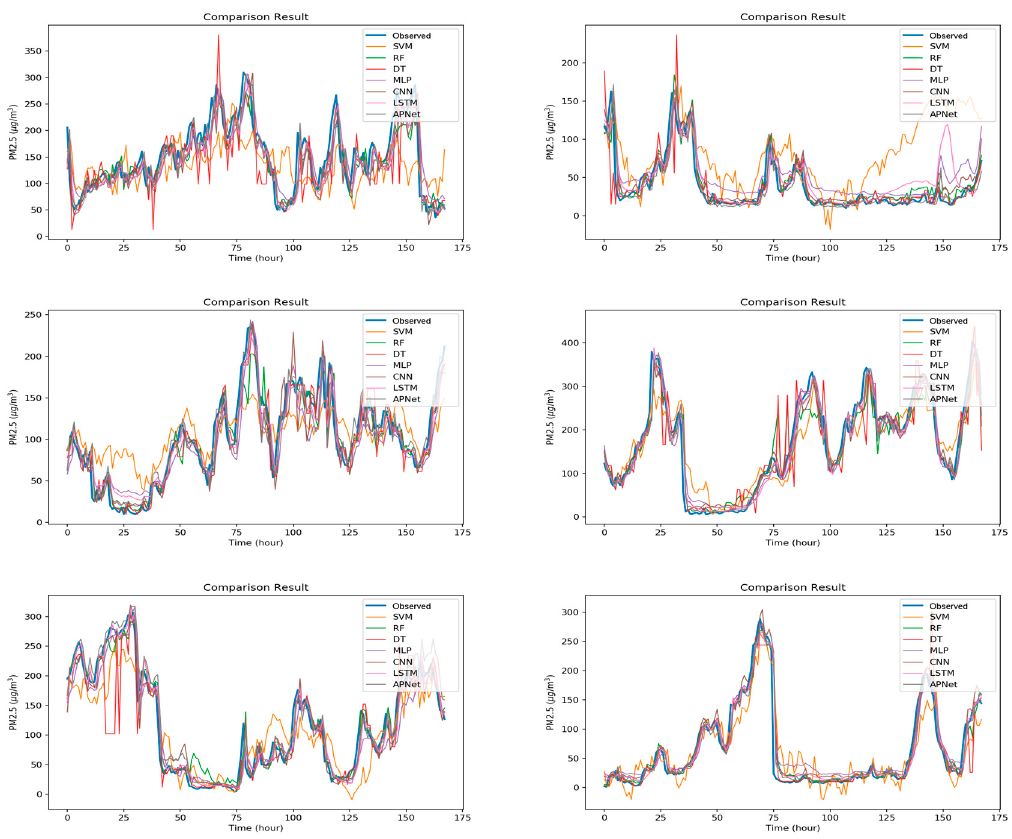
Figure A7. The forecasting results of the proposed APNet.